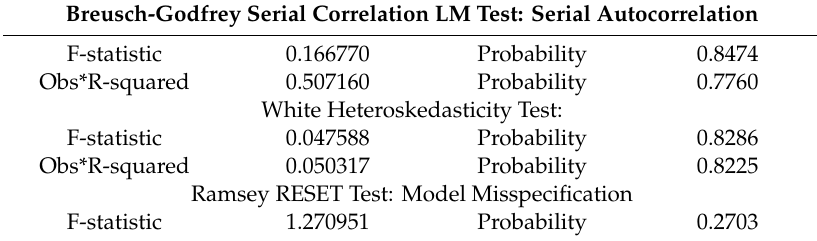
Table 10. Diagnostic tests for the stability of the ARDL